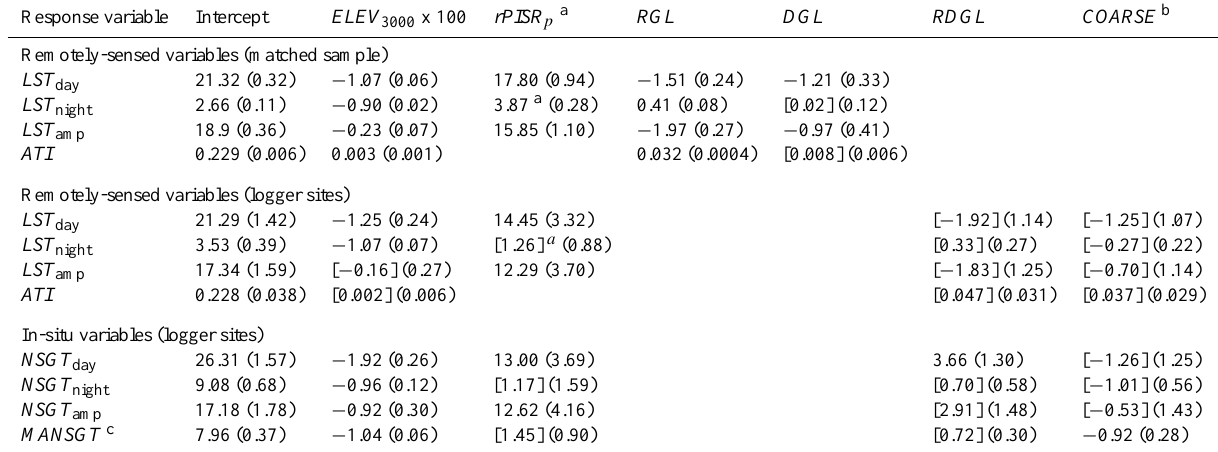
Table 5. Linear mixed models relating remotely-sensed and in-situ ground thermal variables to site characteristics at the logger sites and in the matched random sample. Non-significant coefficients in square brackets, FDR of all tests controlled at ≤ 10 %, no tests on the intercept.